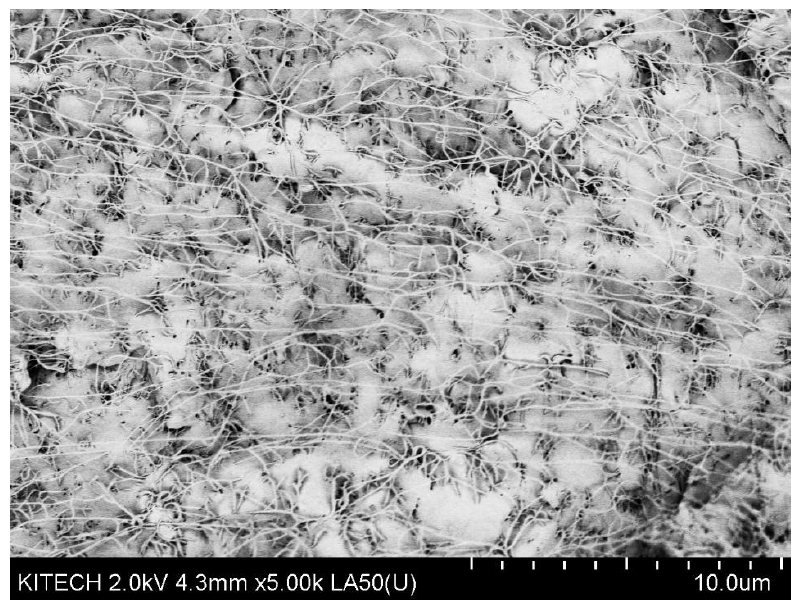
Figure A3. SEM image of the 2.94 wt.% SWNT/PP composite.